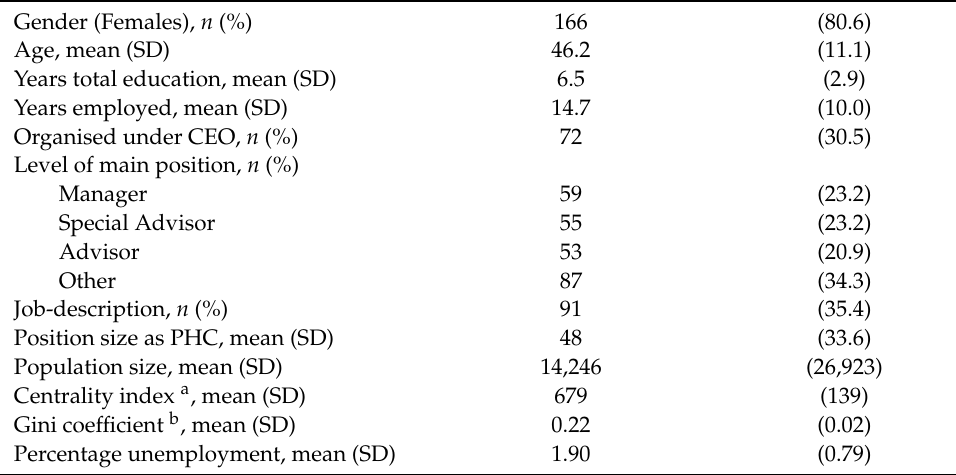
Table 2. Characteristics of